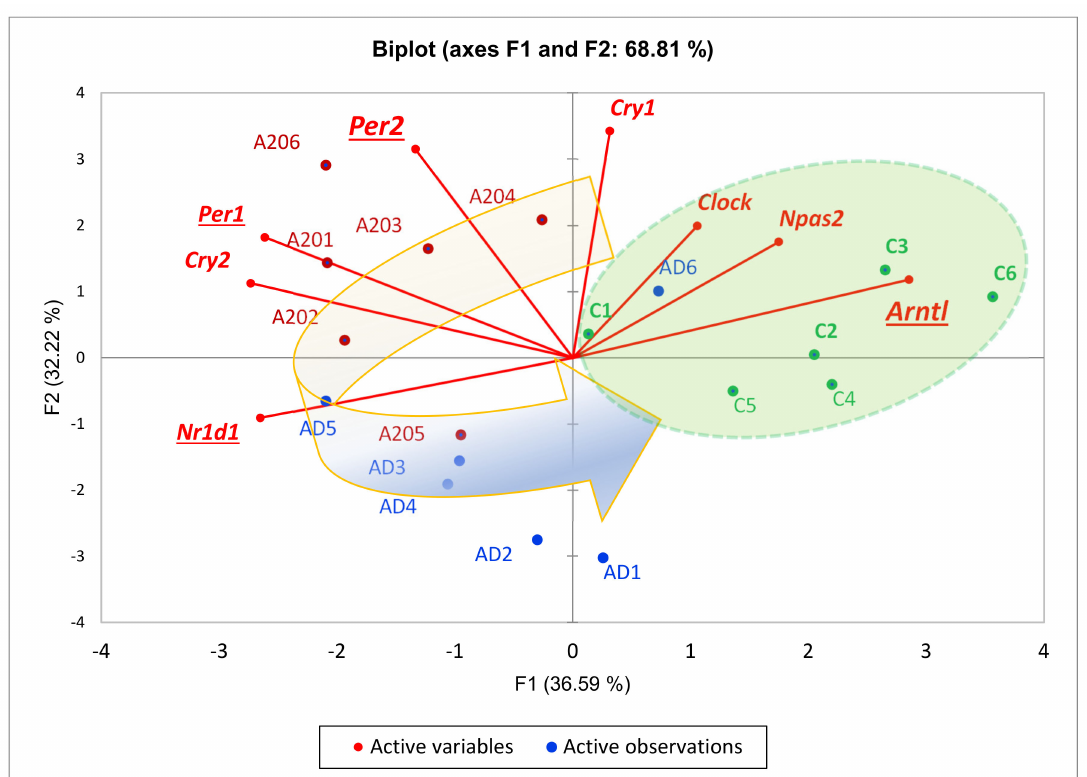
Figure 6. Circadian rhythm TF set (8 genes; Figure 5) PCA biplot featuring a control-group-associated Arntl DEG (Figure 3A) along with experimentally confirmed (string-db) connected genes Npas2, Clock (green shaded area) that are attenuated in affected species due to repressive action of cAMP- associated Per1 expression in aggressive mice. H0: random distribution of species across plot’s 2 halves: p < 0.0024; binomial test. Each gene statistically significantly correlates with at least 2 other genes ( p < 0.05) except for Clock (Table 2). Curved arrow depicts group-related sequential gene expression dynamics cycle: C->A20->AD->C. Underlined gene names indicate DEGs in any of the 3-way comparisons. Enlarged underlined genes feature differential expression in 2 comparisons: